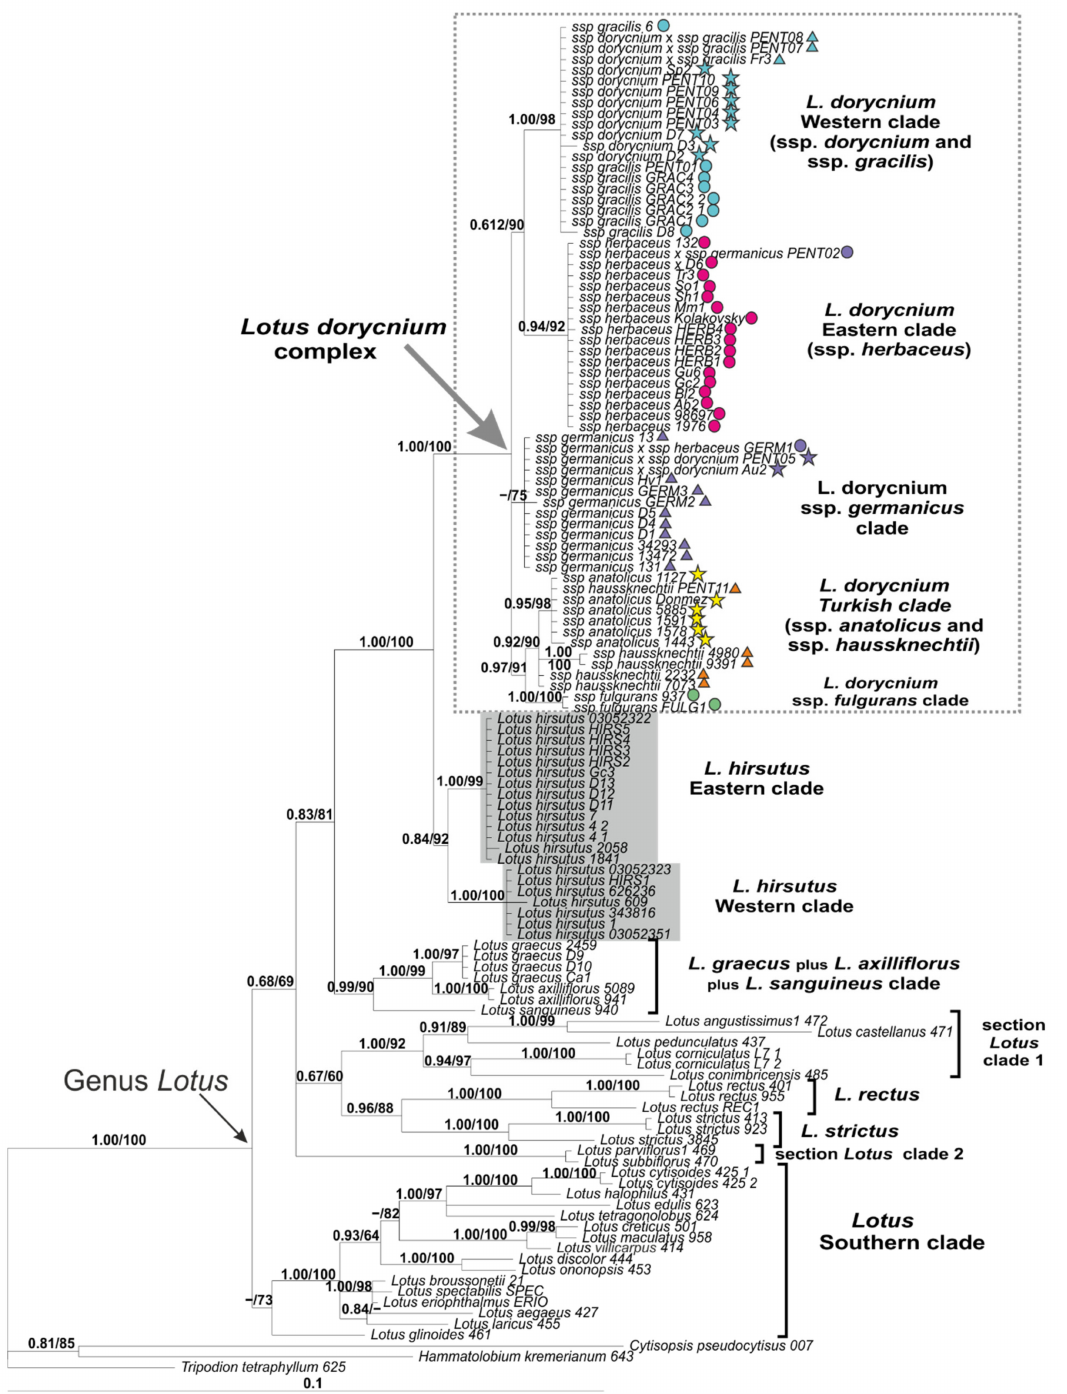
Figure 10. Phylogenetic relationships in Lotus with expanded representation of the L. dorycnium complex inferred from Bayesian analysis of the nrITS dataset. Branch lengths are proportional to the number of expected nucleotide substitutions, scale bar corresponds to 0.1 substitutions per site. Numbers above branches are posterior probabilities. Numbers below branches or after slashes are bootstrap support values found in maximum likelihood (ML) analysis of the same dataset (values equal to or more than 0.6/60% shown). See Table 2 and Appendix A for voucher